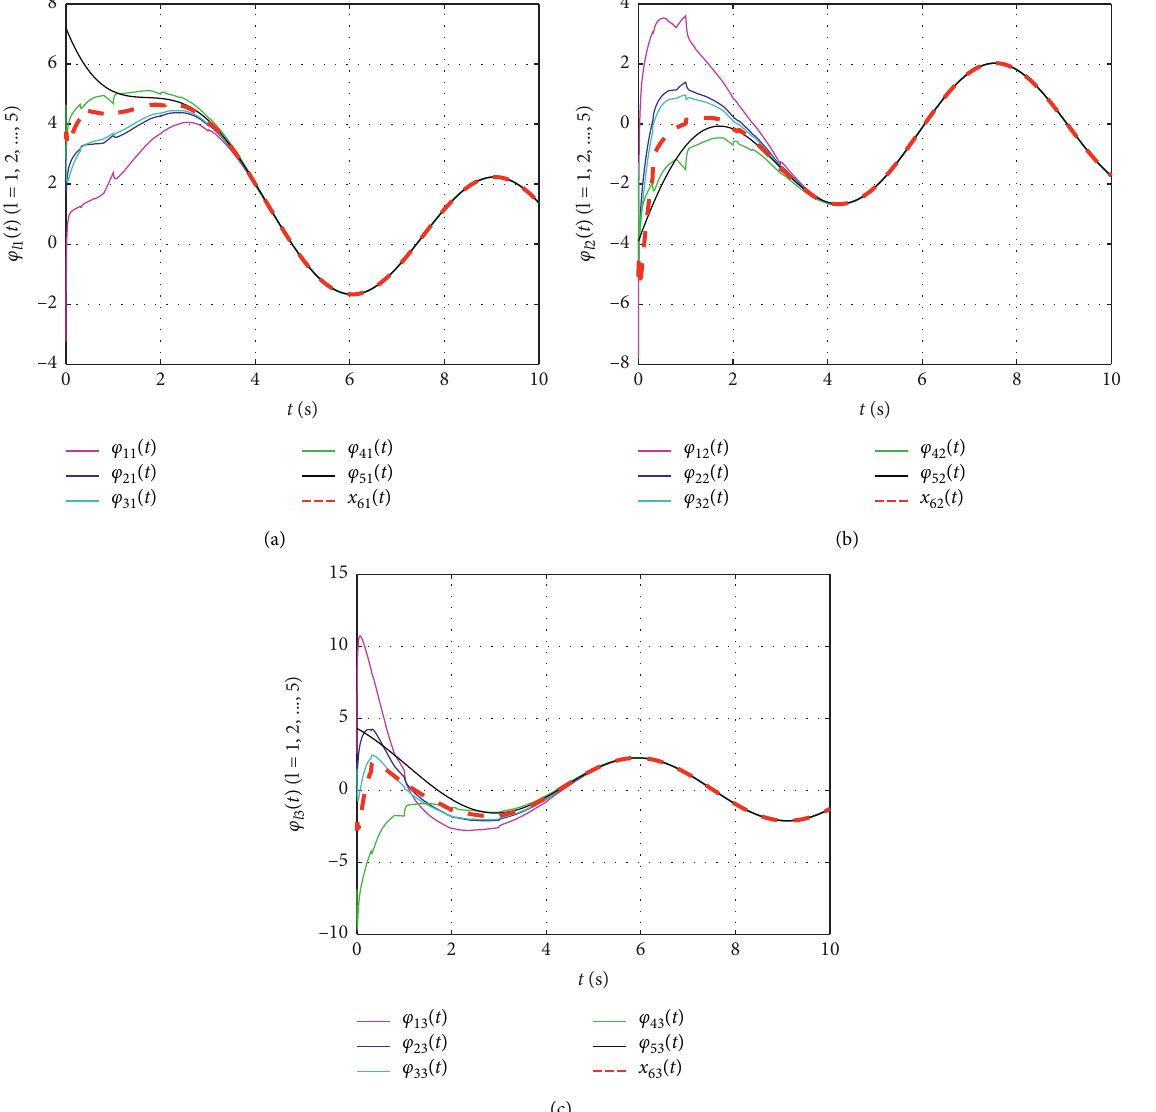
( l � 1 , 2 , ... , 5 ) and that of the l